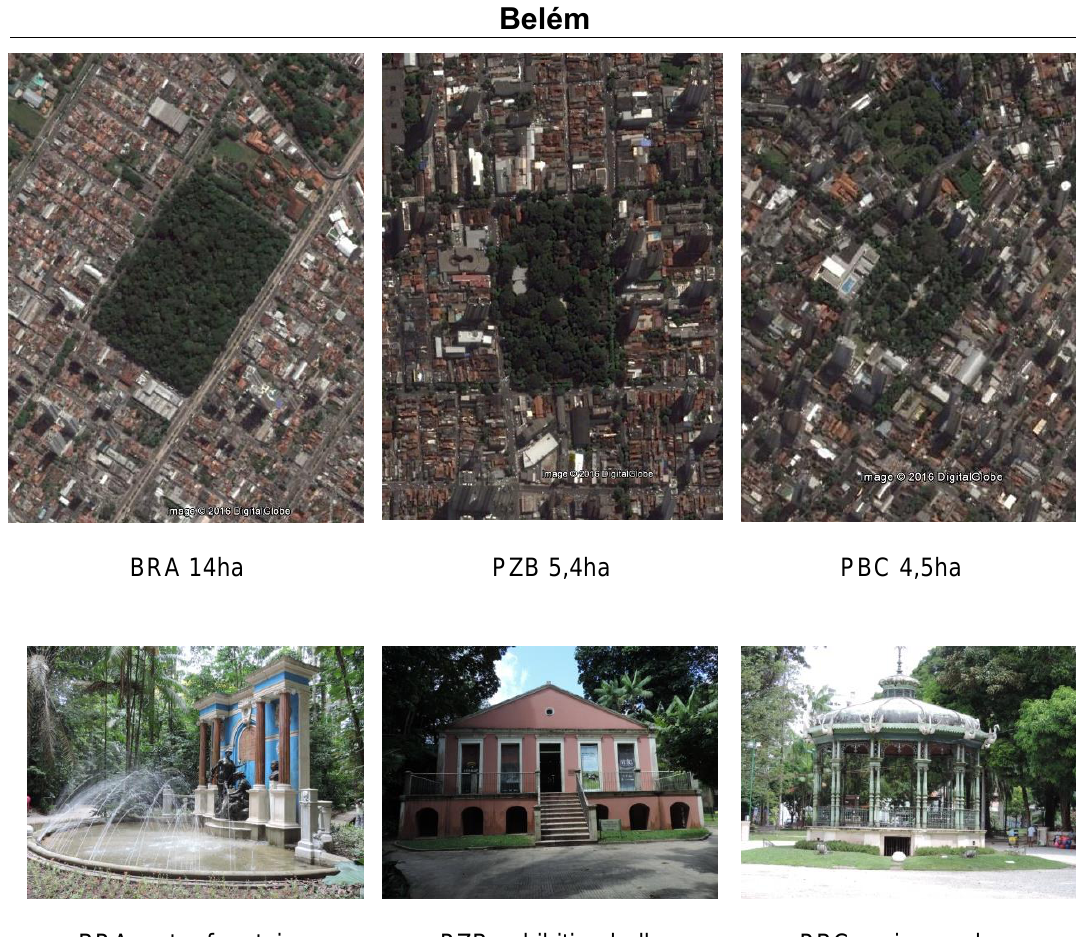
Figure 2: Urban parks in Belém.